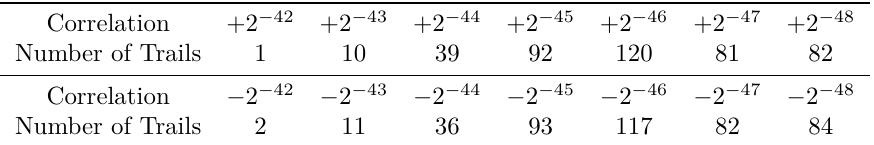
Table 6: Correlations of 850 linear trails for 384-round P b [ l 1